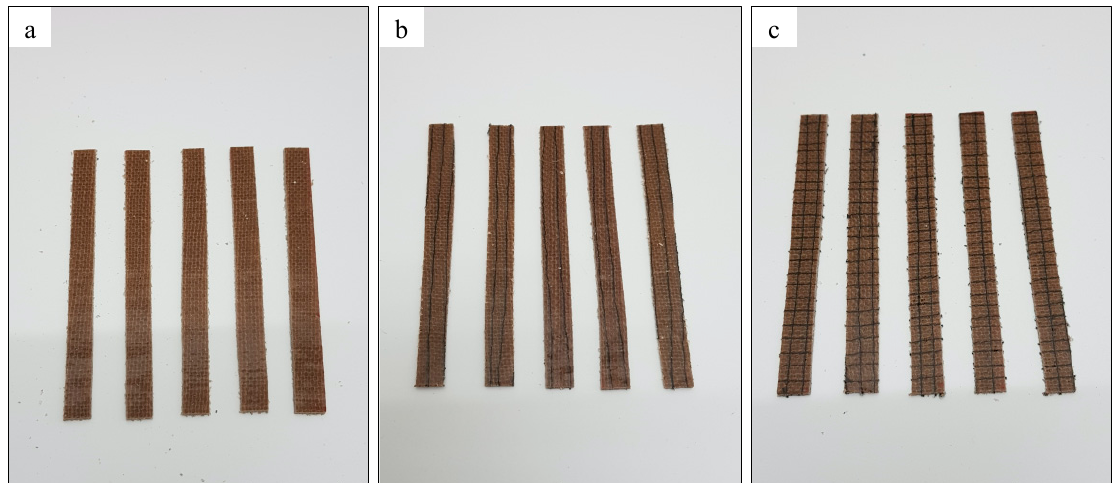
Figure 6. Flexural test setup using an Instron universal testing machine model 3365.